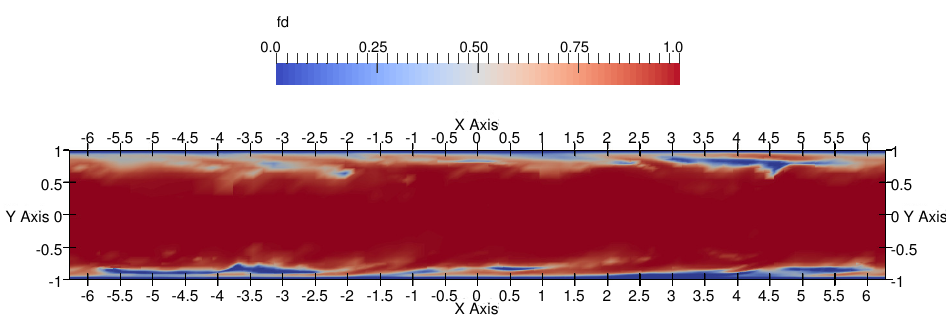
Figure 10. WA-DDES of supersonic channel flow: instantaneous contours of the blending